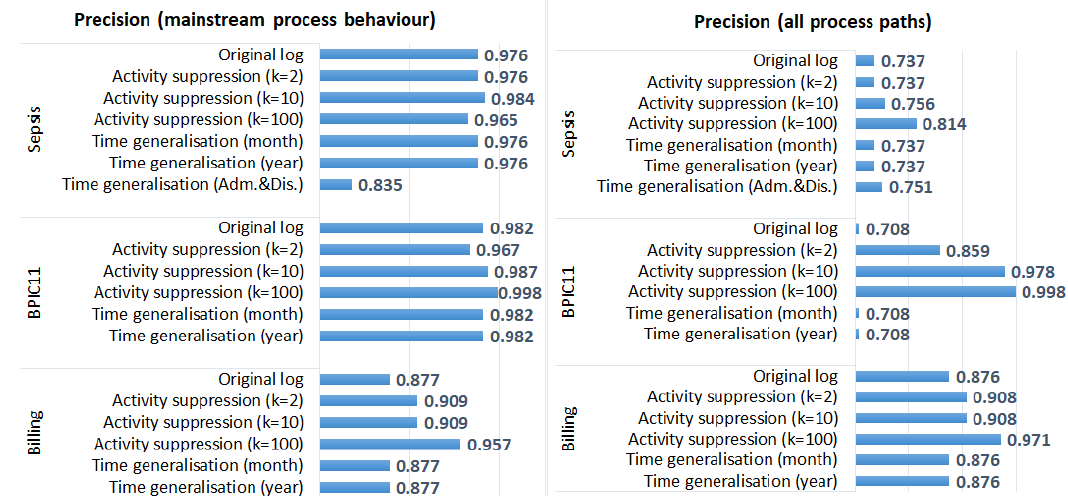
Figure 3. The impact of activity suppression and time generalisation on the results of process discovery: fitness values for the three event logs.